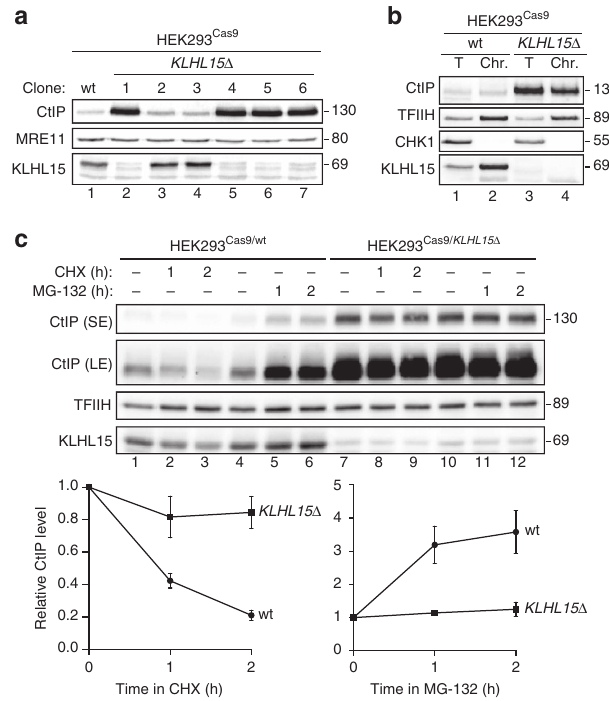
Figure 3 | CtIP protein turnover is impaired in KLHL15 knockout cells. ( a ) Lysates from a stable HEK293 Cas9 wild-type (wt) cell clone or from six different HEK293 Cas9 cell clones generated with the same sgRNA targeting KLHL15 (see Supplementary Fig. 3a) were subjected to western blotting with the indicated antibodies. ( b ) Total (T) cell extracts and chromatin- enriched (Chr.) fractions of HEK293 Cas9/wt and HEK293 Cas9/ KLHL15 D cells were analysed by immunoblotting using the indicated antibodies. ( c ) Same cells as in b were either mock-treated, treated with CHX (100 m gml (cid:2) 1 ) or MG-132 (20 m M) for the indicated time points and lysates were subjected to western blotting with the indicated antibodies (upper panel). SE and LE; short- and long-exposure times of the same immunoblot. Relative CtIP protein levels were determined by quantification of CtIP band intensity (normalized to TFIIH) with the ImageJ software (lower panels). Data are represented as mean values of densitometric quantification ± s.e.m. ( n ¼ 3). NATURE COMMUNICATIONS|7:12628|DOI: